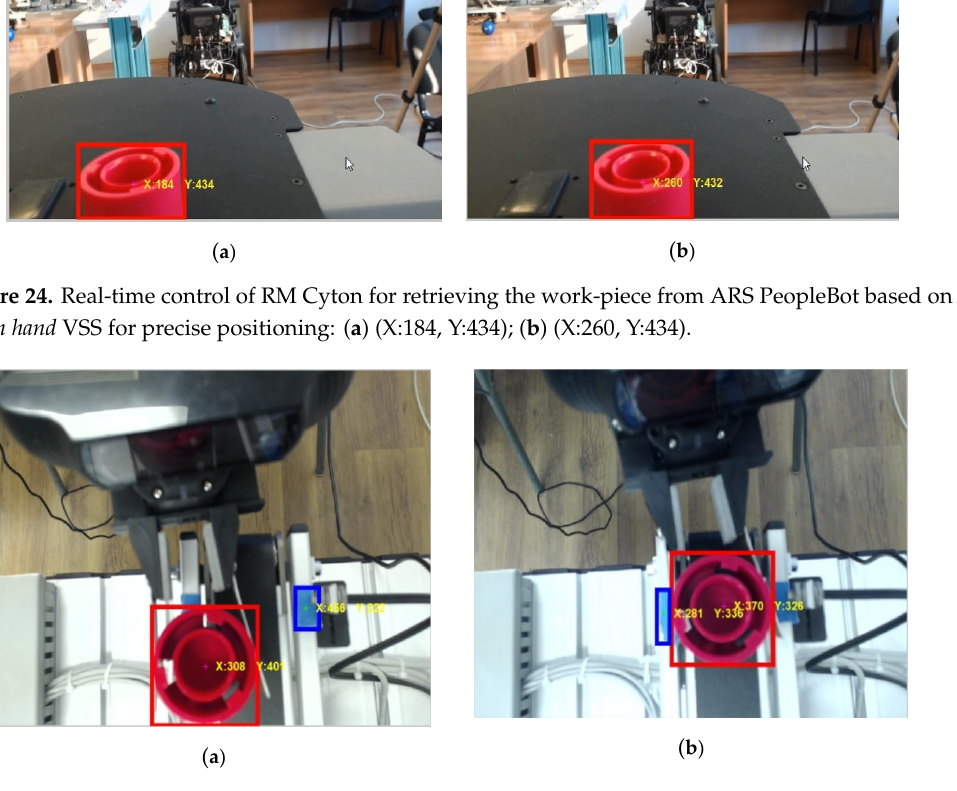
Figure 25. Real-time control of RM Cyton for releasing the work-piece on P//RML based on eye to hand VSS 2 as actuator for precise positioning: ( a ) piece position=(X:184, Y:434), relative position=(X:456, Y324); ( b ) piece position= (x = 260, y = 434), relative position=(X:370, Y326)